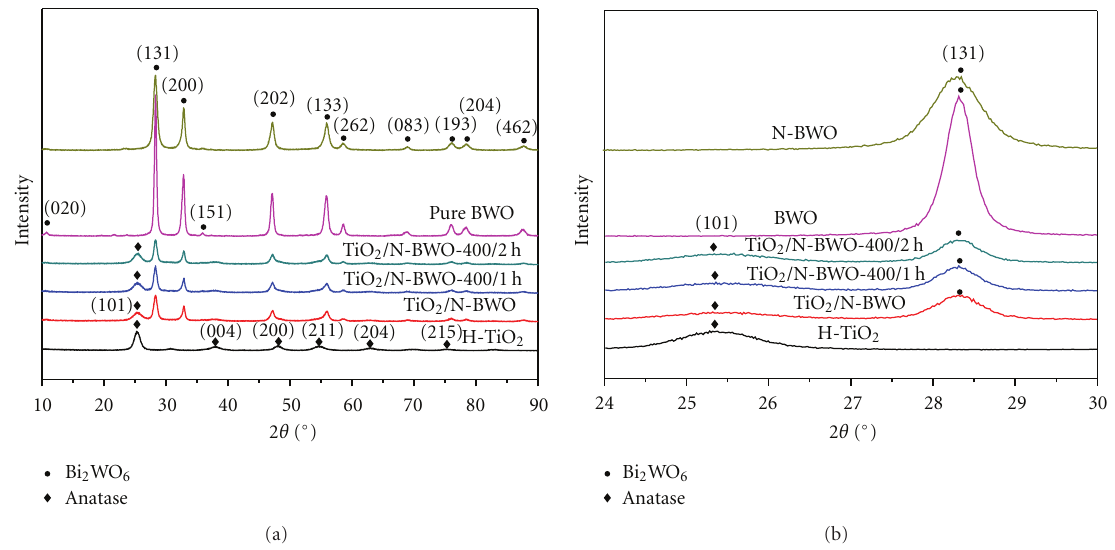
Figure 1: XRD patterns of TiO 2 /N-BWO, TiO 2 /N-BWO-400/1 h, TiO 2 /N-BWO-400/2 h, BWO, N-BWO, and H-TiO 2 .